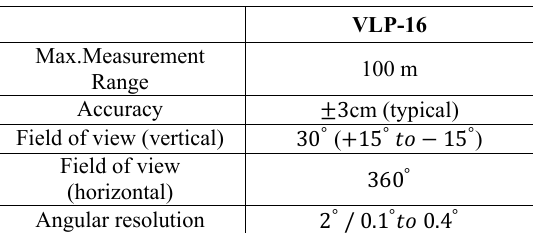
Table 2. Performance characteristics of Velodyne